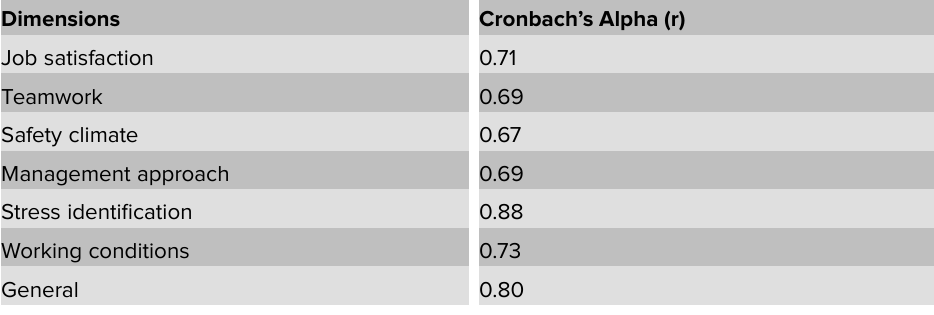
Table 1: Reliability coefficients of the